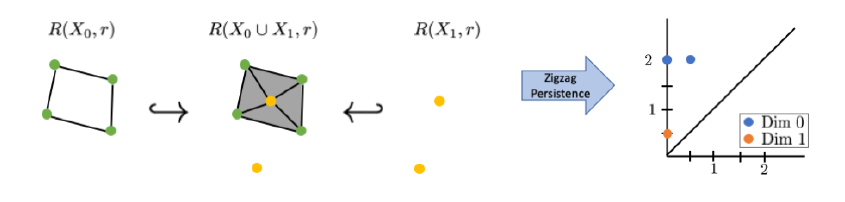
Figure 1. A small example of zigzag filtration with a corresponding zigzag persistence